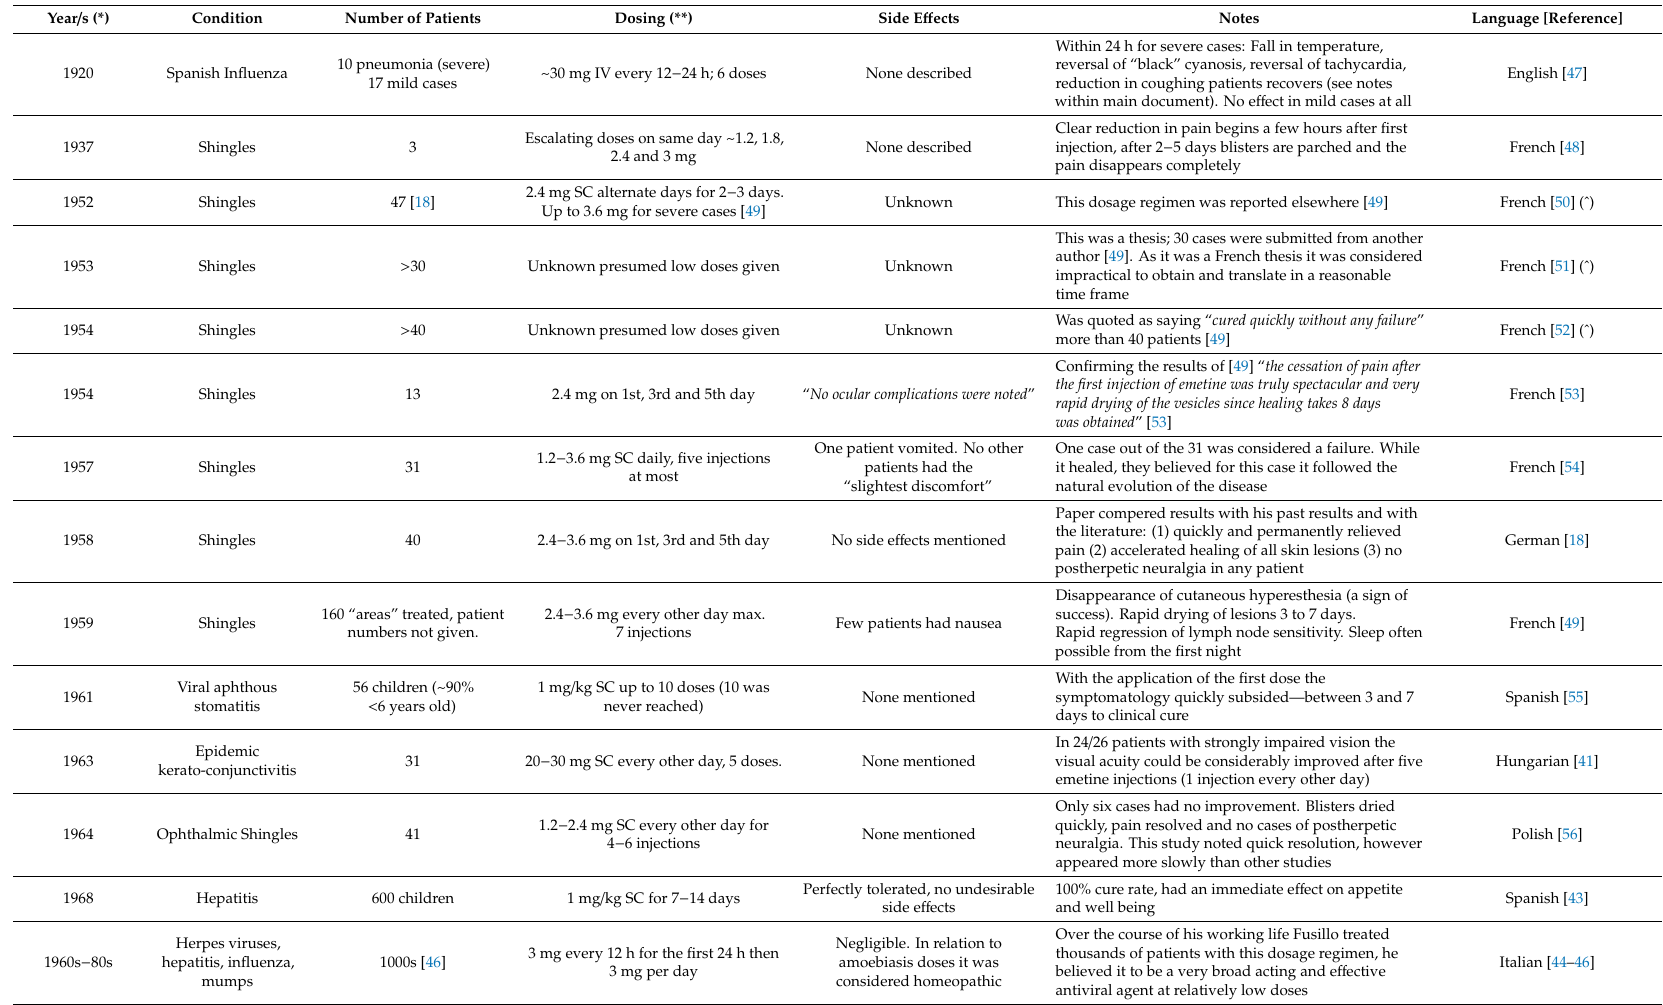
Table 2. Emetine use as an antiviral agent in